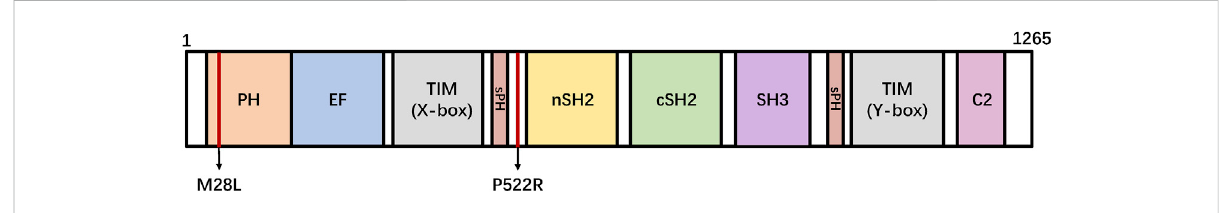
FIGURE 1 Linear representation of the domains of PLC γ 2. PLCG2 M28L and P522R variants are shown in the domain architecture. N amino-terminus, C carboxyl-terminus,PH:pleckstrinhomologydomain,EF:EF-handmotif,TIM:TIMbarrel,sPH:splitPHdomain,nSH2:n-terminusSrcHomologytwo